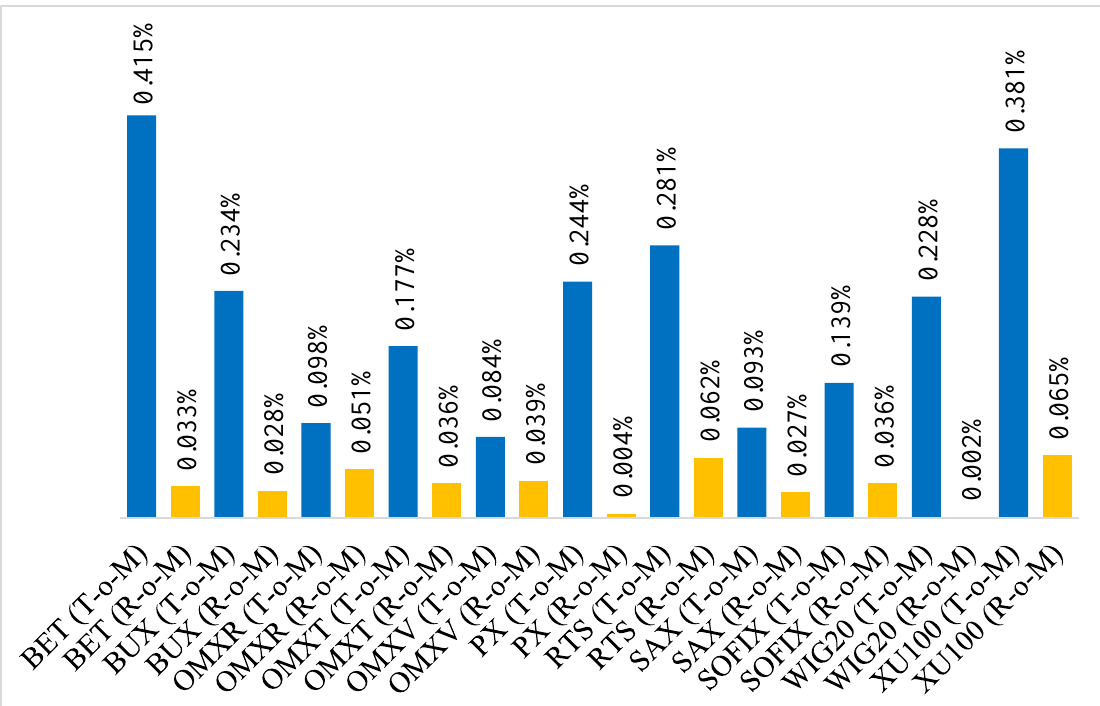
Table 2. Results of the statistical significance tests—Turn of the month window (1+1).